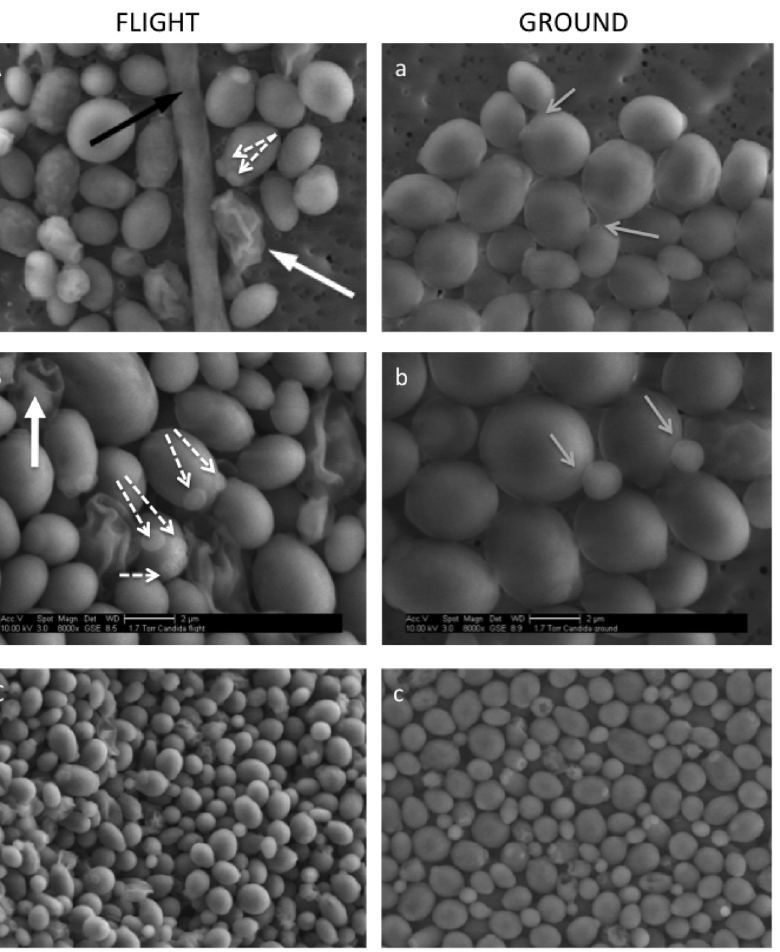
Figure 4. Scanning electron microscopy analysis of C.albicans cultured in spaceflight and ground control conditions. Cell clusters of spaceflight (A, B) and ground control (a, b) conditions are shown. Black arrow points to filament, white arrows indicate aberrant cell shapes, grey arrows indicate normal bipolar budding, and white dotted arrows indicate random budding scars. Magnification =5,000 6 for A and a, and 8,000 6 for B and b. C and c show images of spaceflight and ground control cells respectively at lower magnification (2,500 6 ) to demonstrate the difference in space occupancy between the test conditions (3D architecture for spaceflight compared to flat structure for ground cultures).